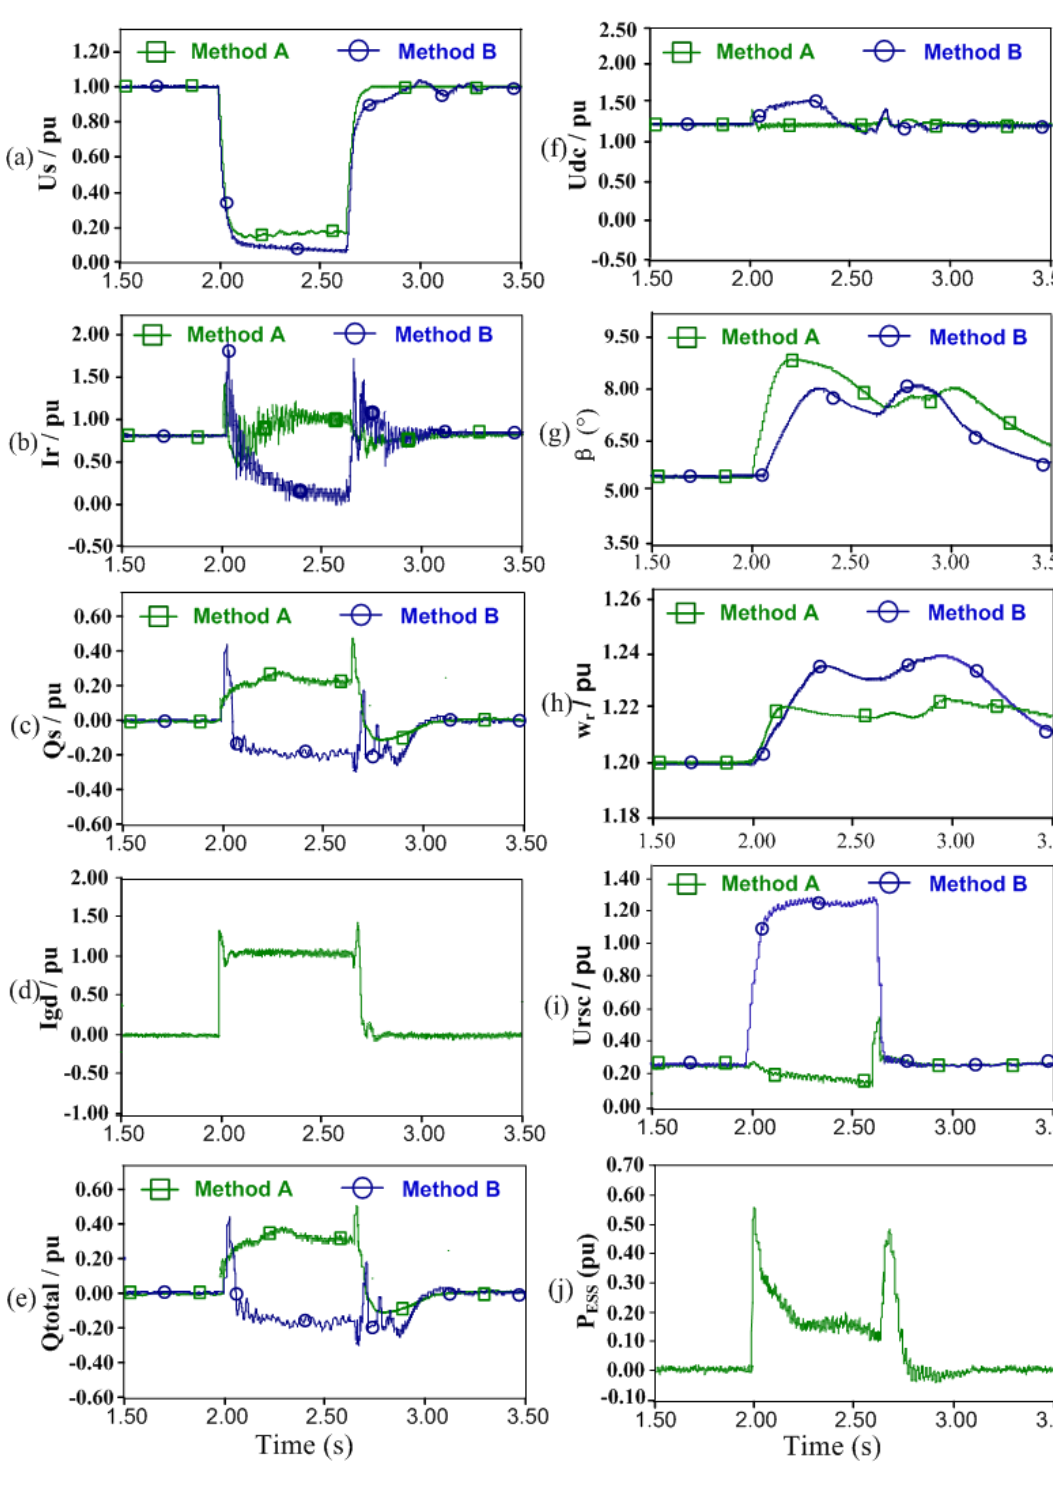
Figure 12. Transient responses of the DFIG-ESS with Method A and B with serious balanced voltage drops: ( a ) terminal voltage; ( b ) rotor current; ( c ) reactive power output of the stator; ( d ) reactive current of the GSC; ( e ) total reactive power output of the DFIG; ( f ) DC-link voltage; ( g ) pitch angle; ( h ) rotor speed; ( i ) voltage of the RSC; and ( j ) active power of the